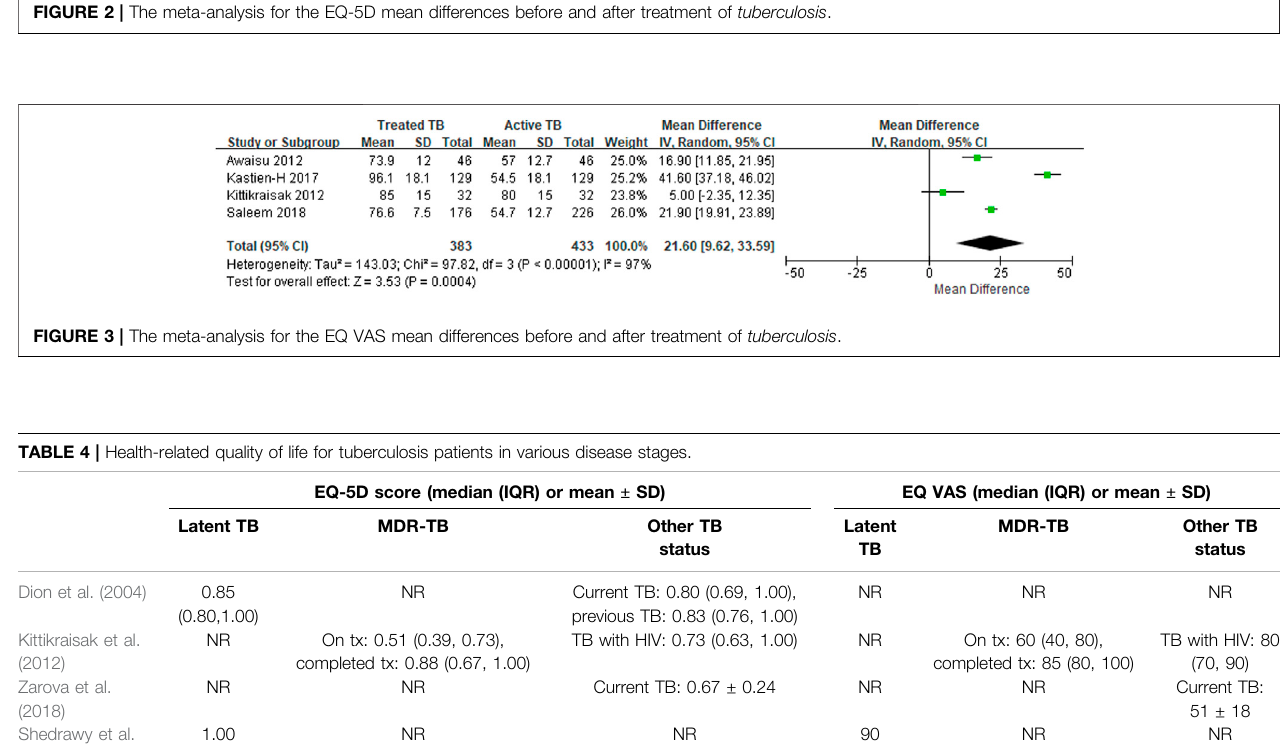
FIGURE 2 | The meta-analysis for the EQ-5D mean differences before and after treatment of tuberculosis .